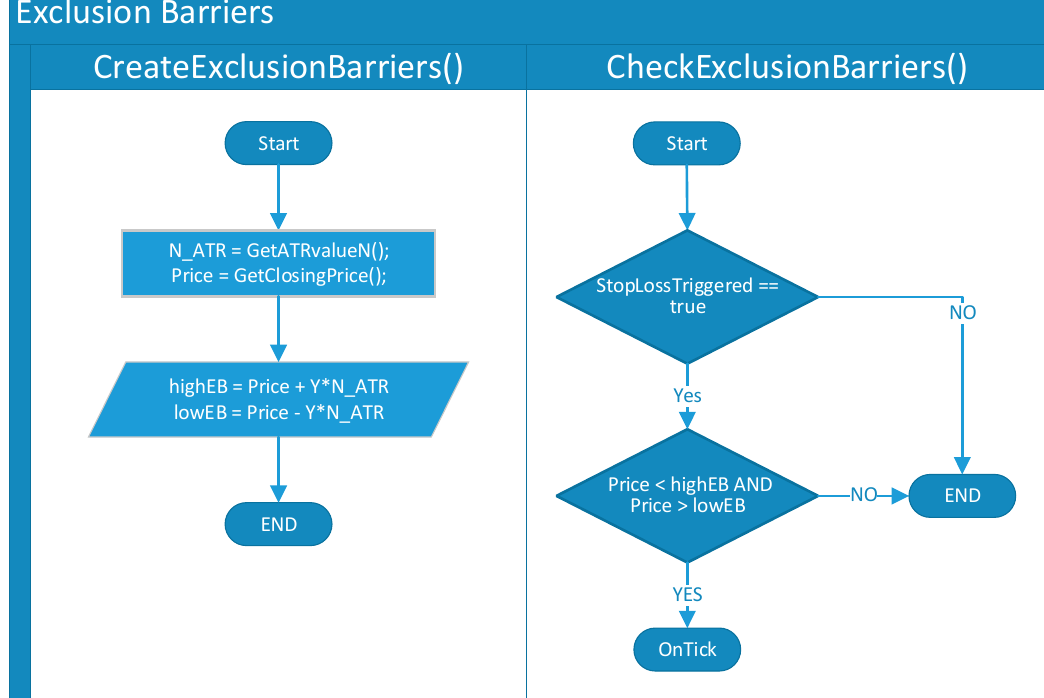
Figure 6. Creating the exclusion zone after a stop loss was triggered and preventing the opening of a new position until the price level escapes the upper or lower exclusion barrier.